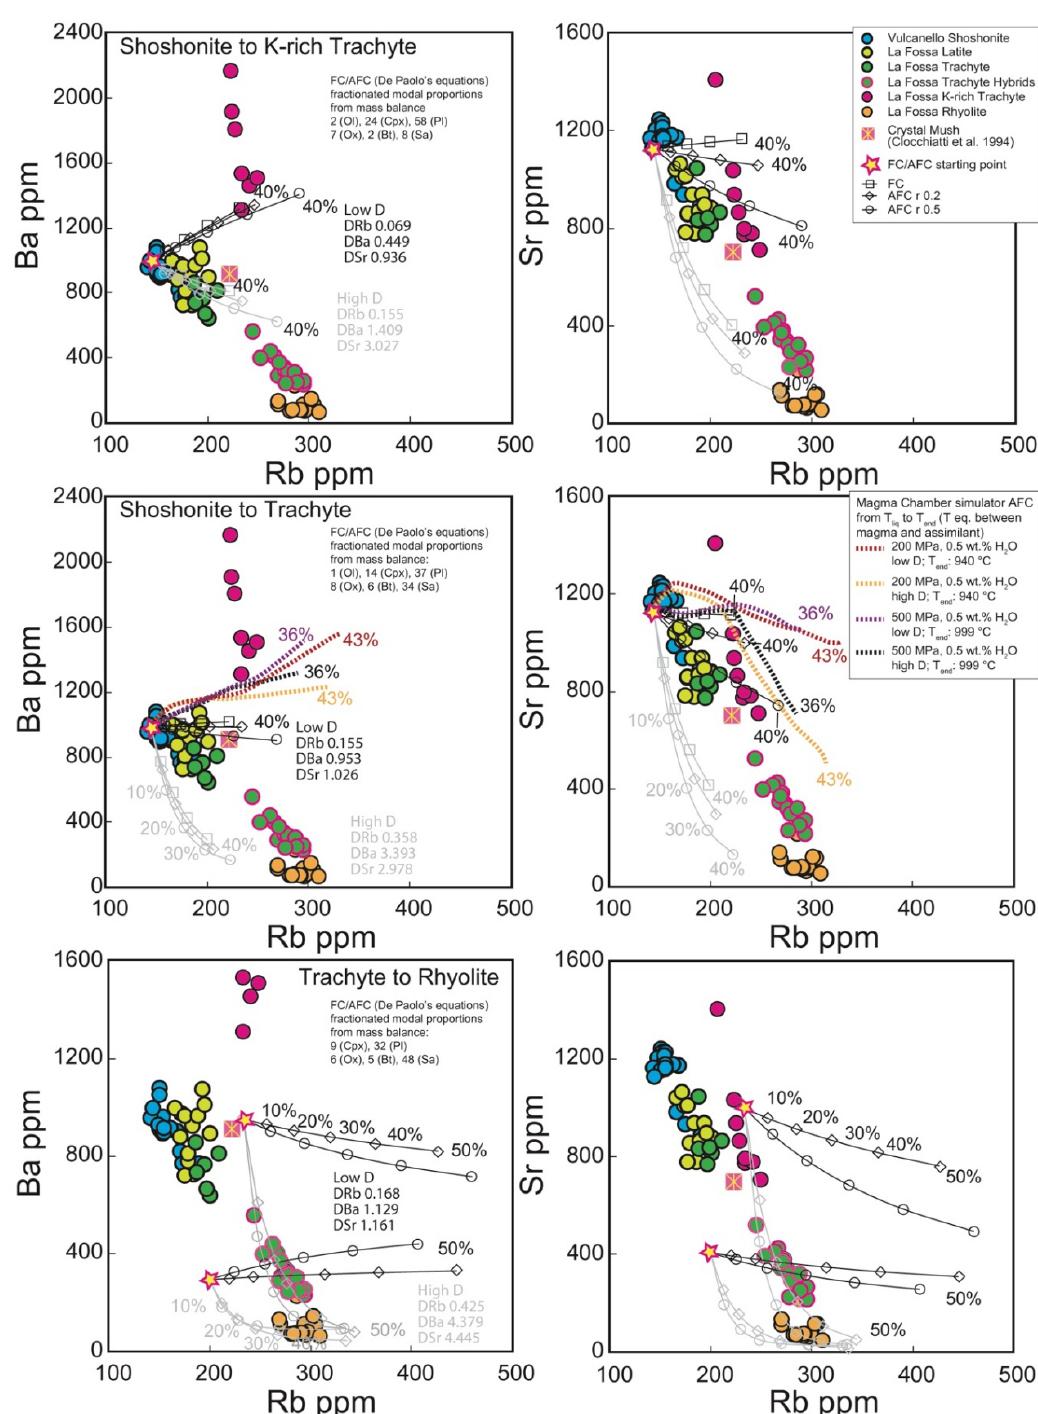
Figure 6: FC and AFC trace element modelling for the magmatic differentiation at La Fossa obtained by using the equations of [56] and the MCS code (in middle panels). The used bulk D have been estimated using modal mineral assemblages of the relative proportions of crystallizing phases obtained through the mass balance calculations [21] and selected mineral/melt partition coefficients and by the phase equilibria produced by MCS (see the text for further explanations and Supplementary Tables S6 and S7). The numbers at the ends of the differentiation paths refer to the crystal fractions. Literature data sources as in Figure 2. Only MCS runs performed at 0.5 wt.% H 2 O are showed for the sake of simplicity (see Supplementary Table S7 for the runs performed at 4 wt.% H 2 O).